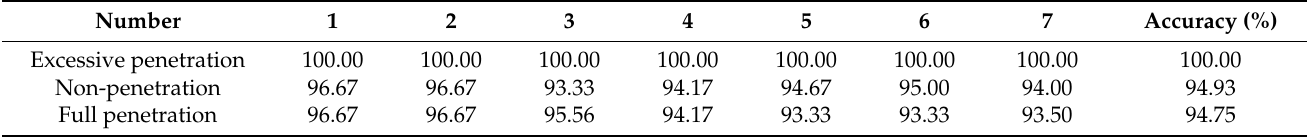
Table 2. Validation accuracy in three penetration states (VGG16,